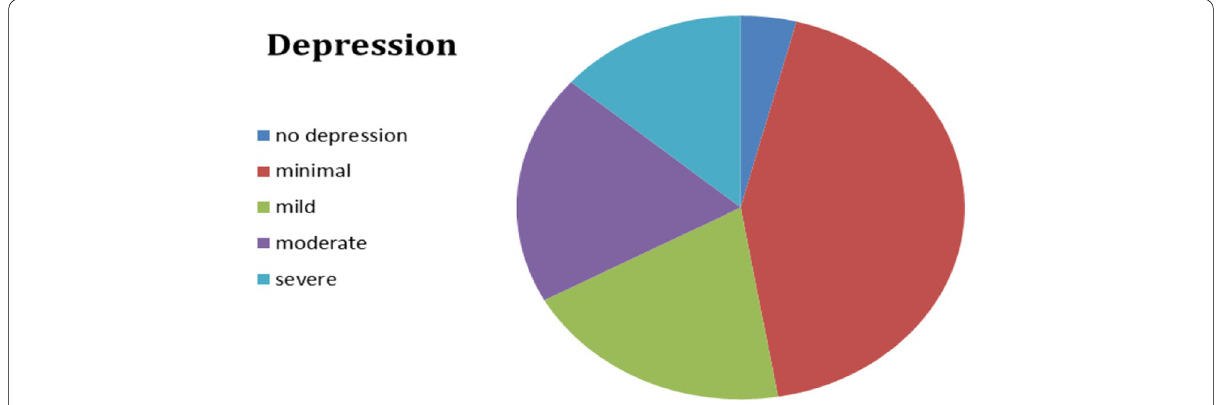
Fig. 1 Assessment of depression in the studied patients